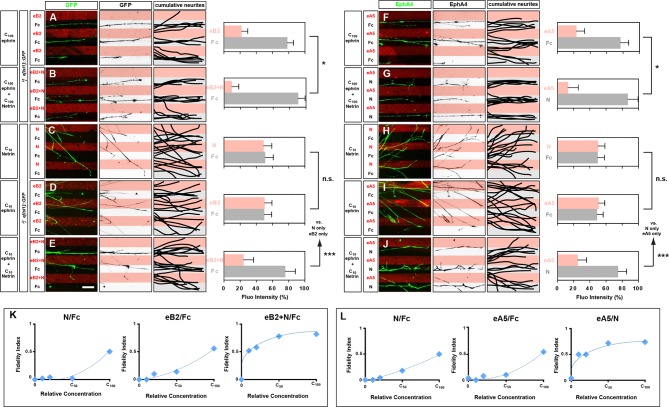
Congruent and opposing modes of Netrin and ephrin synergy in cultured LMC axons.(A–J) Left panels: explanted medial (GFP+) LMC neurites of e[Isl1]::GFP-electroporated explants on C100 eB2-Fc/Fc (A), C100 eB2-Fc + C100 N/Fc (B), C10 N/Fc (C), C10 eB2-Fc/Fc (D), C10 eB2-Fc + C10 N/Fc (E) stripes and explanted lateral (EphA4+) LMC neurites on C100 eA5-Fc/Fc (F), C100 eA5-Fc/ C100 N stripes (G), C10 N/Fc (H), C10 eA5-Fc/Fc (I), or C10 eA5-Fc/C10 N (J) stripes. Middle panels: inverted images where GFP (A–E) or EphA4 (F–J) signal is dark pixels overlaid on substrate stripes. Right panels: superimposed images of five representative explants from each experimental group highlighting the distribution of LMC neurites. Quantification of medial (GFP+) or lateral (EphA4+) LMC neurites on first (pink) and second (pale) stripes expressed as a percentage of total GFP (A–E) or EphA4 (F–J) signals. C100 stripes were generated by incubating with ephrins at 10 μg/ml and/or Netrin-1 at 100 ng/ml. Experiments with intervening concentrations (C50 and C25) are shown in Figure 5—figure supplement 1. Minimal number of neurites: 72. Minimal number of explants: 11. (K, L) Plots of relative concentrations (x axis) over the fidelity index (y axis). Medial (K) or lateral (L) LMC neurites were challenged with one of five concentrations (C100, C50, C25, C10, 0) of ephrin or Netrin-1 to test for preferential LMC neurite growth. The fidelity index is the absolute value of: (percent growth on 2nd stripes – 50%)/50%. Index of 1 represents the complete repulsion or attraction of LMC neurites from the 1st stripes, and 0 represents no preference. Note that stripes at C10 concentrations induced little or no preferential LMC neurite growth when only ephrin (middle plots of K and L) or Netrin-1 (left plots of K and L) was presented, but allowed a strong preferential growth of LMC neurites when both cues were present (right plots of K and L). LMC, lateral motor column; N, Netrin-1; eA5, ephrin-A5-Fc; eB2, ephrin-B2-Fc; error bars = SD; *** = p<0.001; * = p<0.05; statistical significance computed using Mann-Whitney U test; All values (mean ± SD) can be found in Supplementary file 1B. Scale bar: 50 µm.